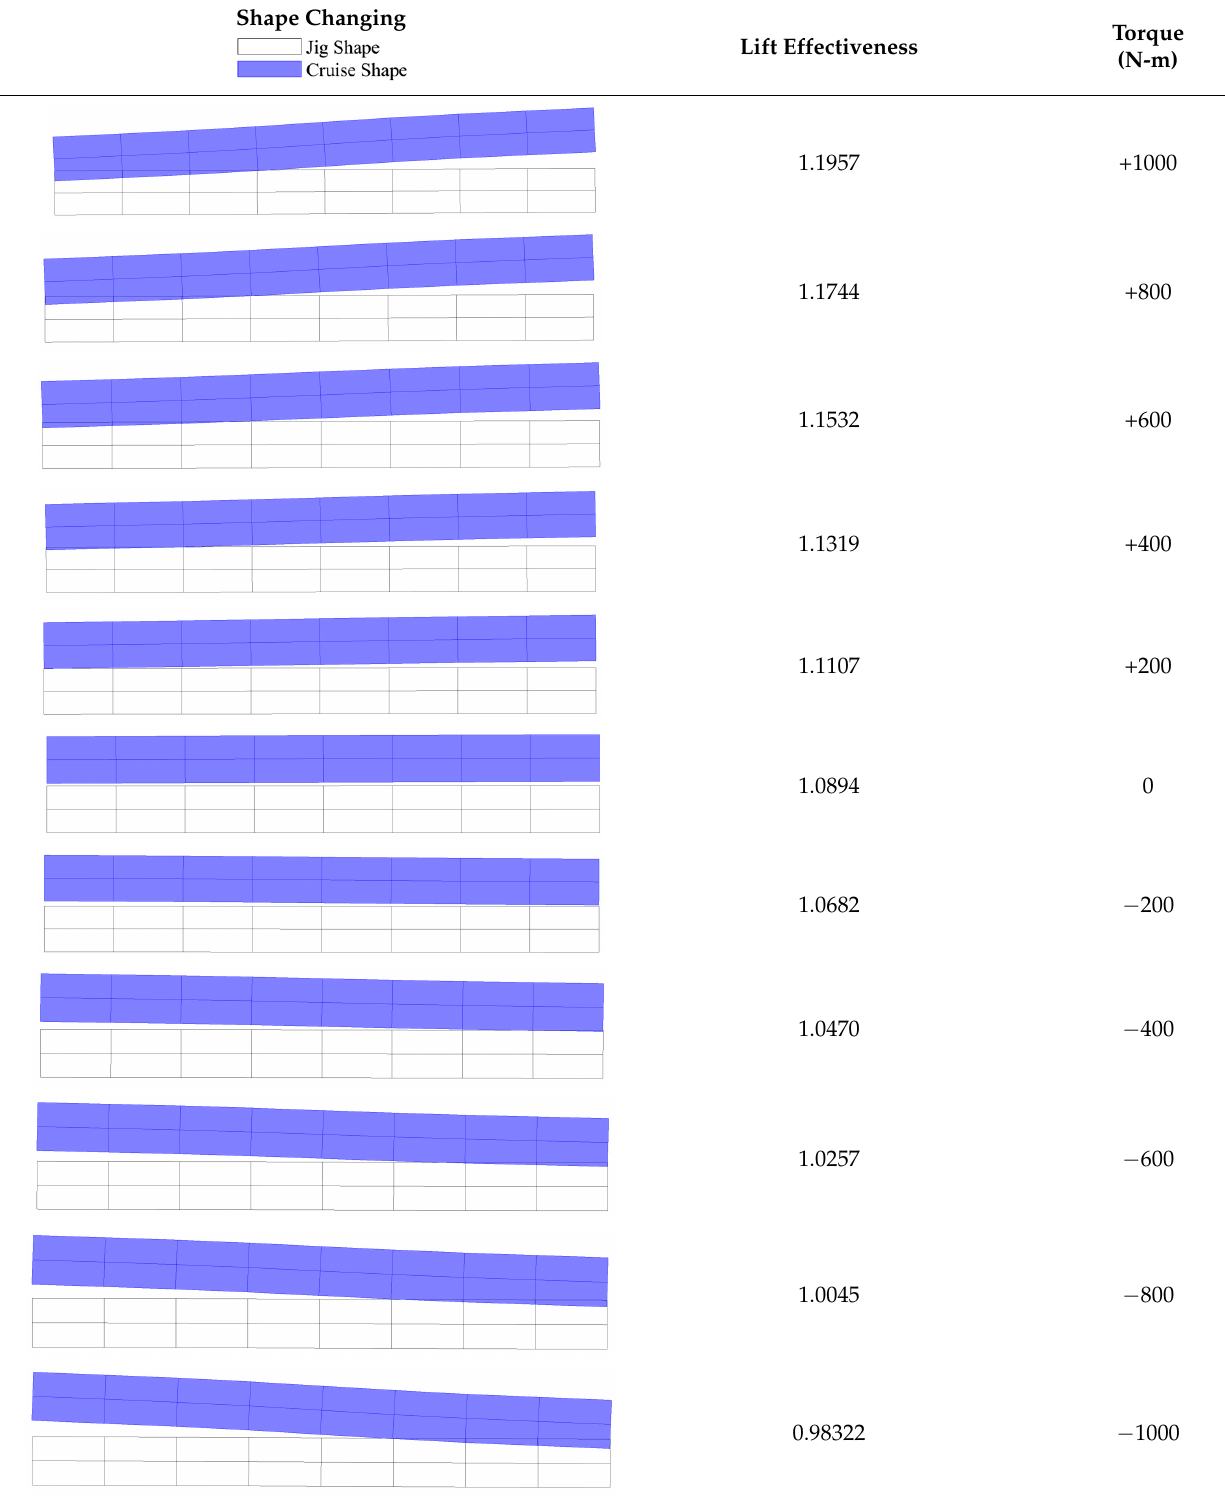
Table 4. Wing box shapes and lift effectiveness due to actuator torques.